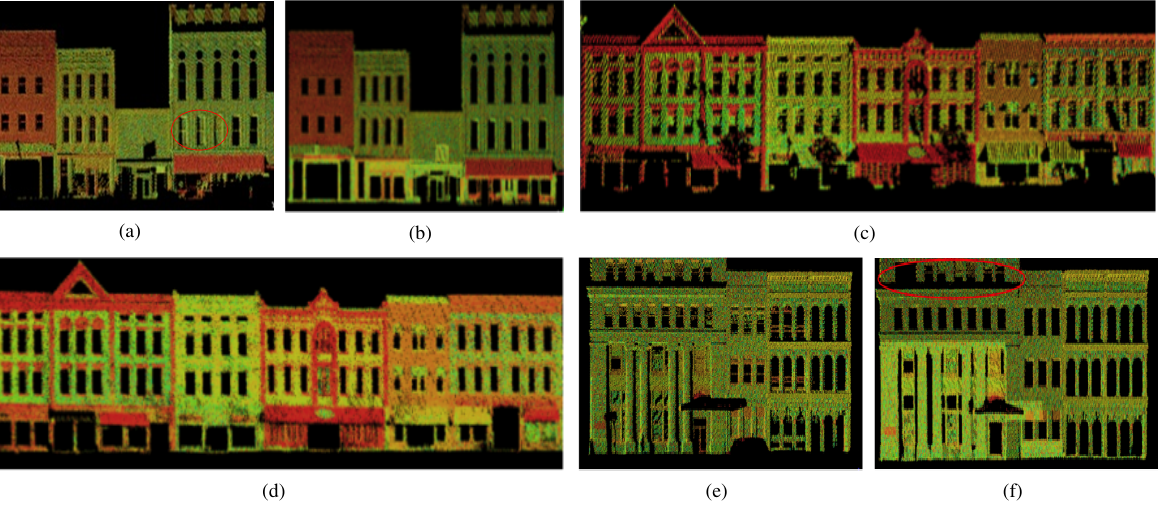
Figure 6: (a) & (c) show raw 3D points (color coded intensity) of different building fac¸ades from the data set containing windows of different types and sizes while (b) & (d) are the corresponding 3D point clouds after window detection and refinement. (b) and (d) clearly demonstrate the efficacy of the method in case of heavy occlusions specially at ground level shop windows. (e) shows the raw 3D points of a building fac¸ade with different non symmetric window patterns. In (f) the same fac¸ade after successful window detection and refinement can be